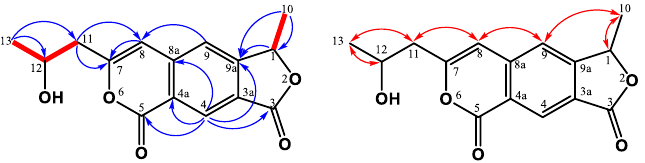
Figure 7. Key 1 H- 1 H COSY ( ━ ), HMBC (H → C), and NOESY (H ↔ H) correlations of 6.